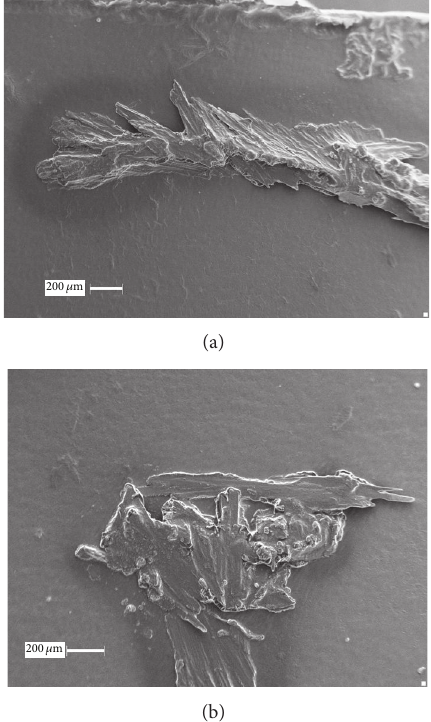
Figure 2: (a) The filiform and bifurcated muscle edges increase physical adhesion to the PET polymer coating; (b) salmon flesh not removed by the urea treatment and adhered to the container wall surface.